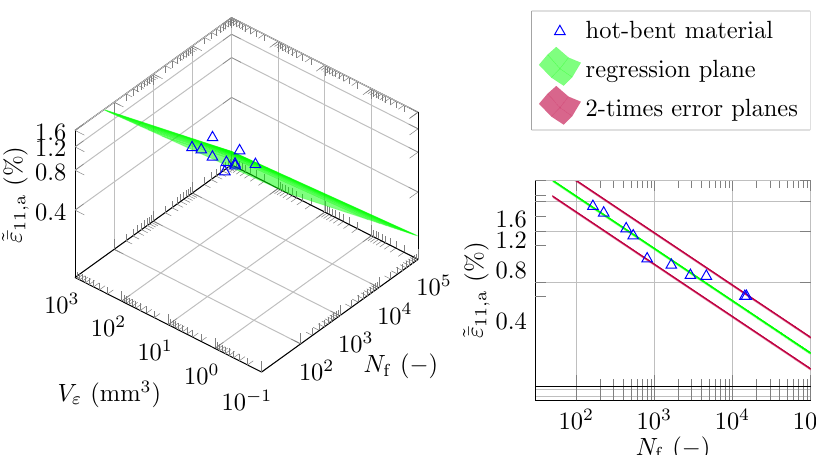
Figure 10. 3D and 2D ˜¯ ε 11,a - V ε - N f fatigue diagrams including the results from the fatigue tests of the hot-bent specimen, the regression surface (green color), and the two 2-times error planes (red color). For the fatigue diagrams, the mean effective strain amplitude ˜¯ ε 11,a is used.